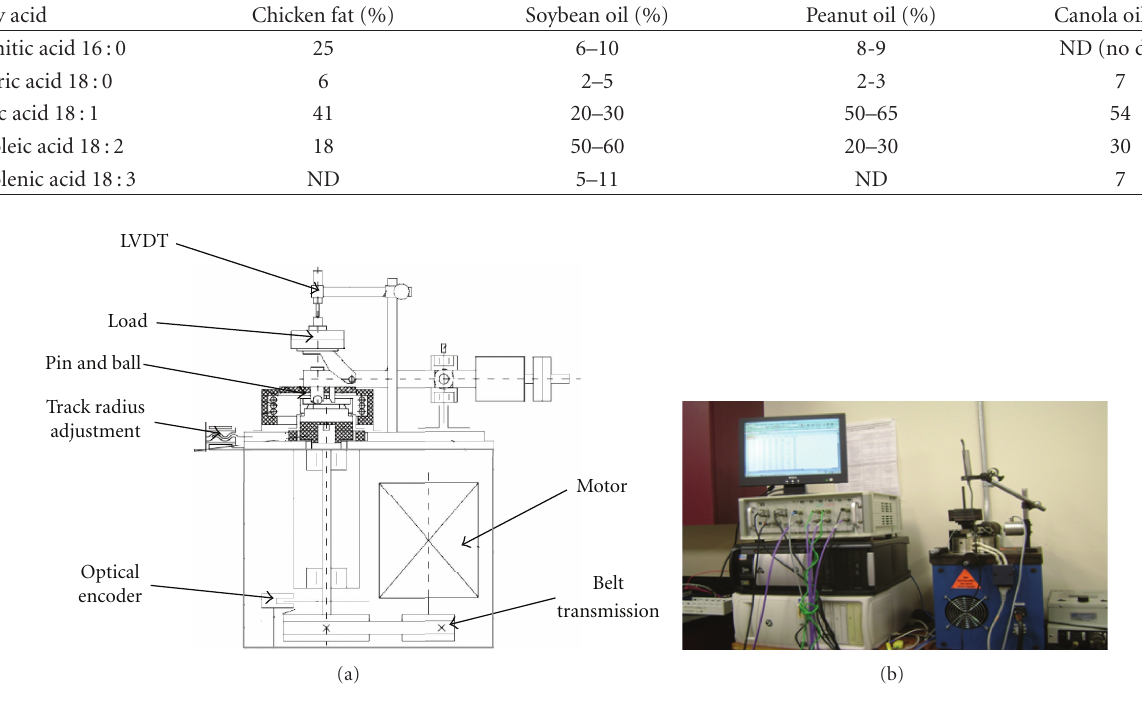
Figure 1: Schematics and photograph of pin-on-disk tribometer and experimental setup.